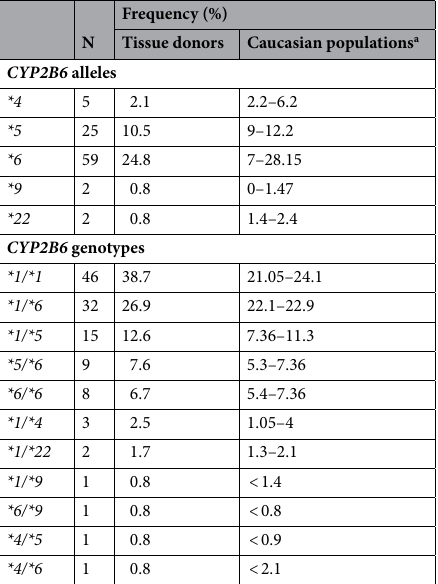
Table 2. CYP2B6 allele and genotype frequencies in liver tissue donors and in Caucasian populations. a Based on PharmVar (https:// www. pharm gkb. org/ page/ cyp2b 6RefM ateri als) 8 .